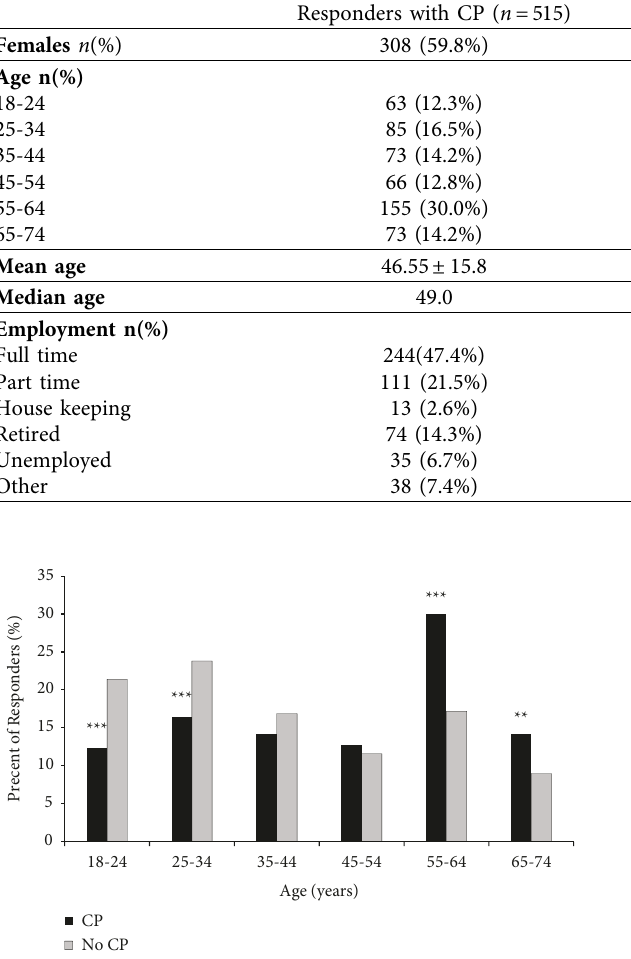
Figure 1: Responders with CP as a percentage of total responders in each group